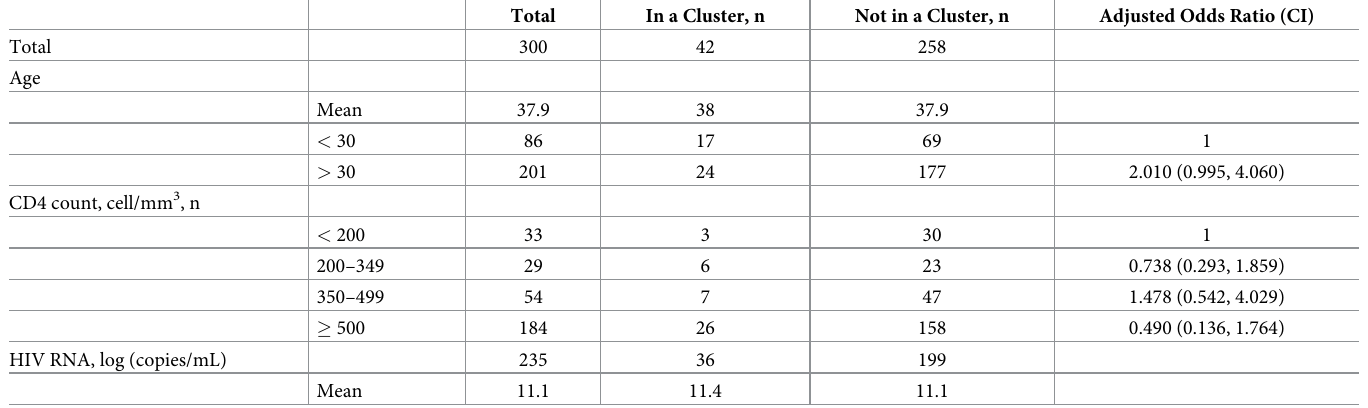
Table 5. Factors associated with cluster membership: MSM